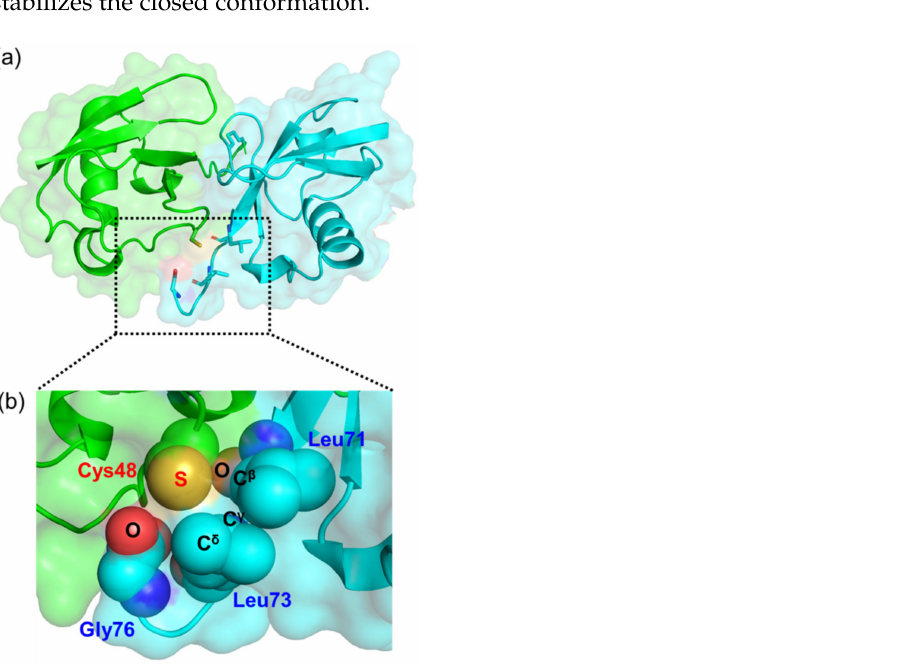
Figure 3. The thiol group in K48C-diUb is a stabilizing factor for its closed conformation. ( a ) Crystal structure of K48C-diUb (present structure; PDB code: 8IC9). Distal and proximal Ub units are shown in green and cyan, respectively. ( b ) The thiol group on Cys48 in the distal unit and its neighboring amino acid residues (Leu71, Leu73, and Gly76) in the proximal unit are shown in the space-filling